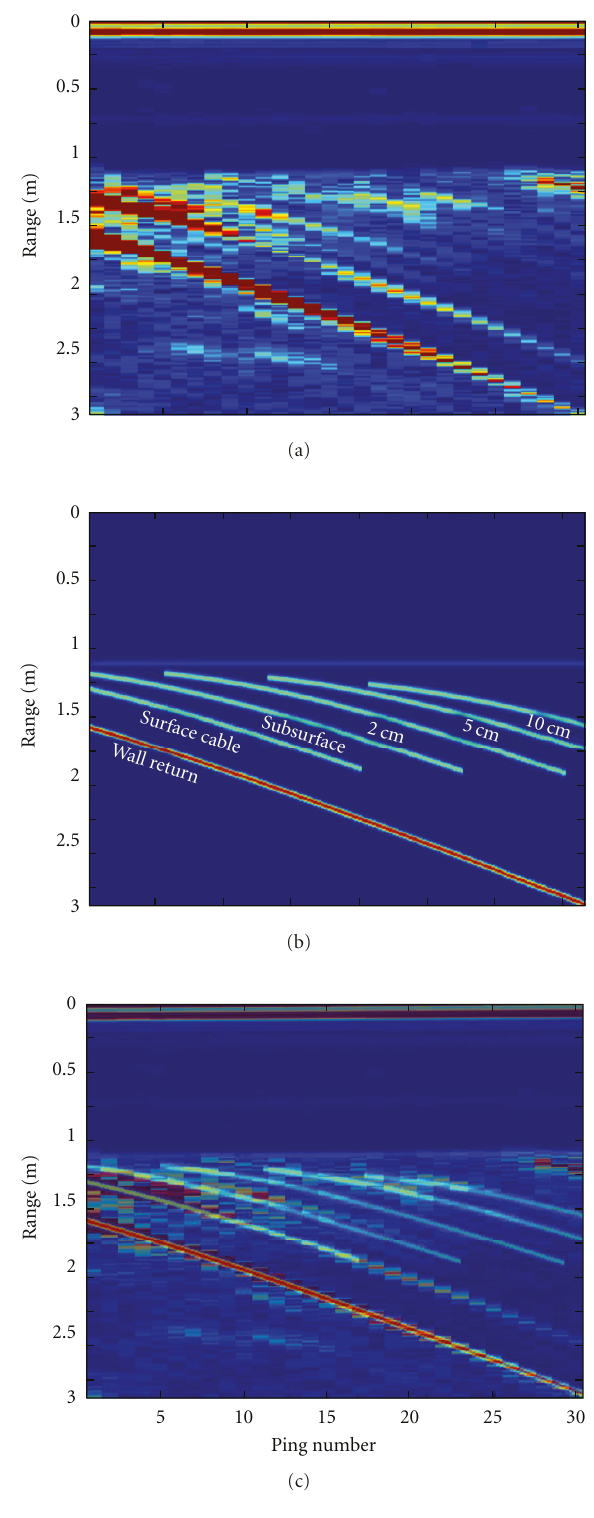
Figure 26: Graphic showing buried cable responses with angle of 27 ◦ : (a) measured responses; (b) expected responses given sensor positions and beam patterns; (c) expected overlaid on measured responses.